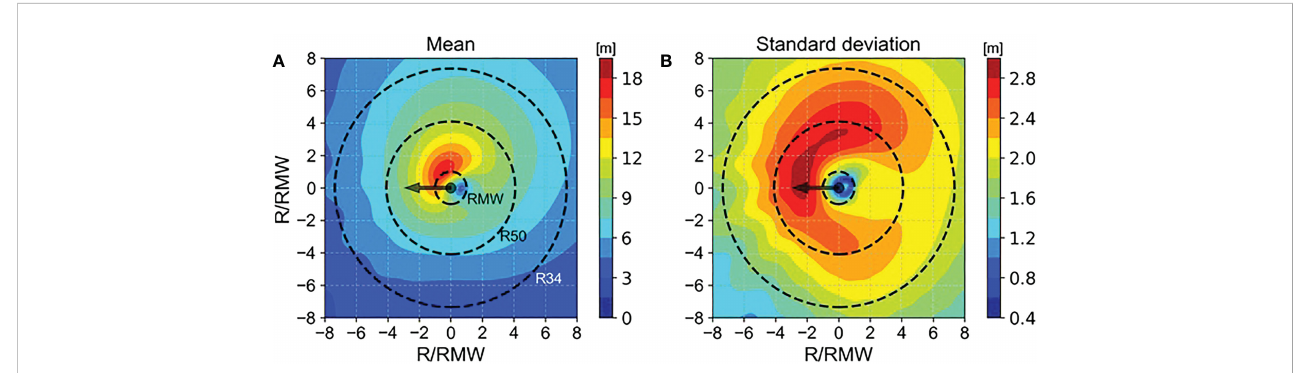
FIGURE 2 The spatial distribution of composited (average) signi fi cant wave heights (A) and their standard deviations (B) obtained from 105 North Atlantic TCs with MWS of 105 knots and V fm of 5.25 m s -1 . Arrows indicate the direction of propagation of the storm. Dashed lines indicate RMW, R50, and R34. All values are expressed on axes normalized in